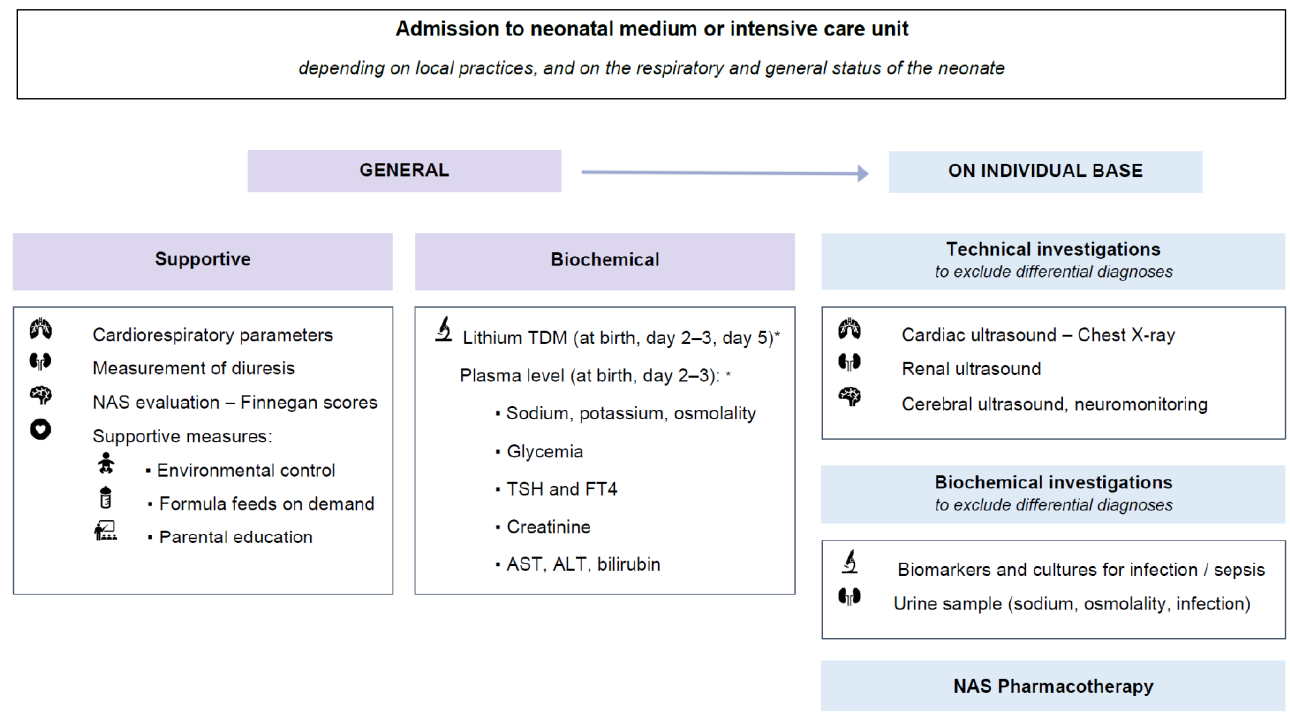
Figure 5. Proposal of postnatal care management of neonates with in utero exposure to lithium. NAS: Neonatal Abstinence Syndrome, TDM: therapeutic drug monitoring, AST: aspartate transaminase, ALT: alanine transaminase, FT4: free thyroxine, TSH thyroid stimulating hormone. * In case of observed/clinically suspected lithium toxicity more frequent (daily) and longer (beyond day 5) TDM is suggested. If TDM < 0.2 mmol/L, further sampling is only recommended in case of symptoms.